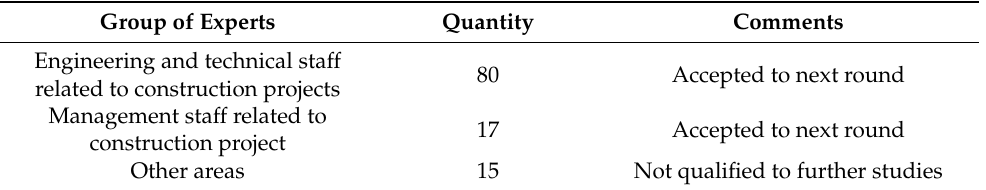
Table 1. Filtering profiles of interviewed